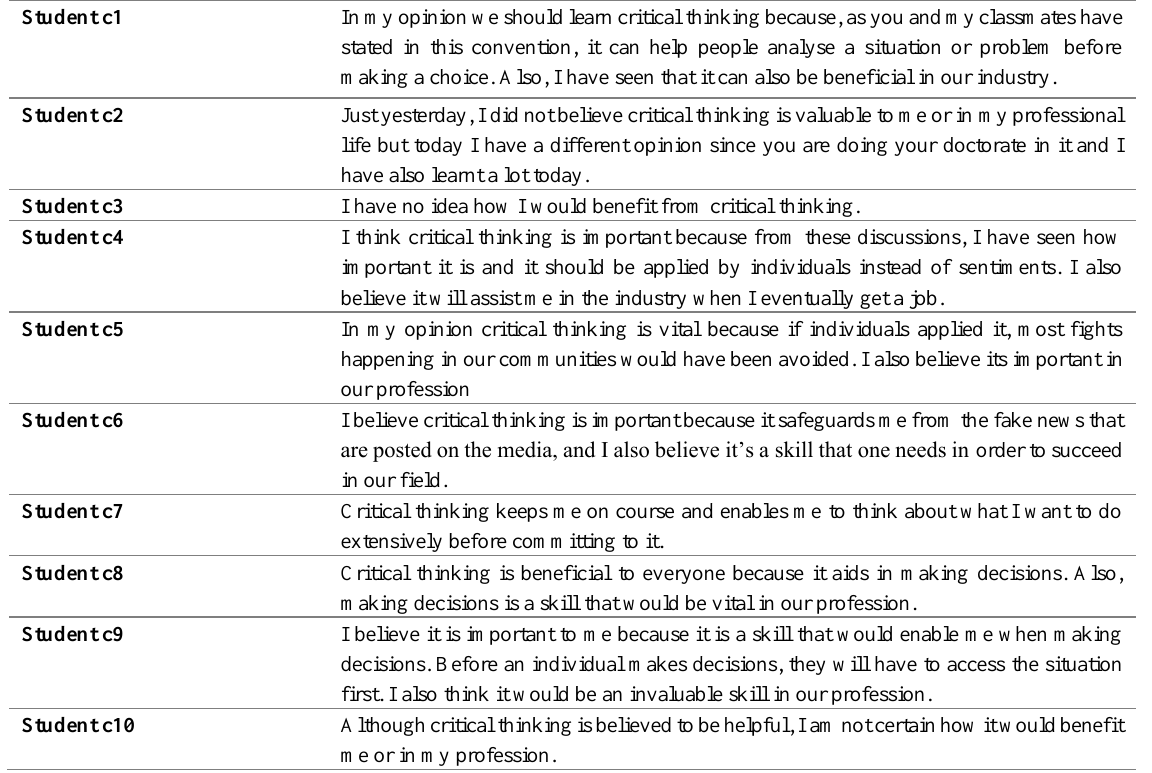
Table 2: Related focus group interview